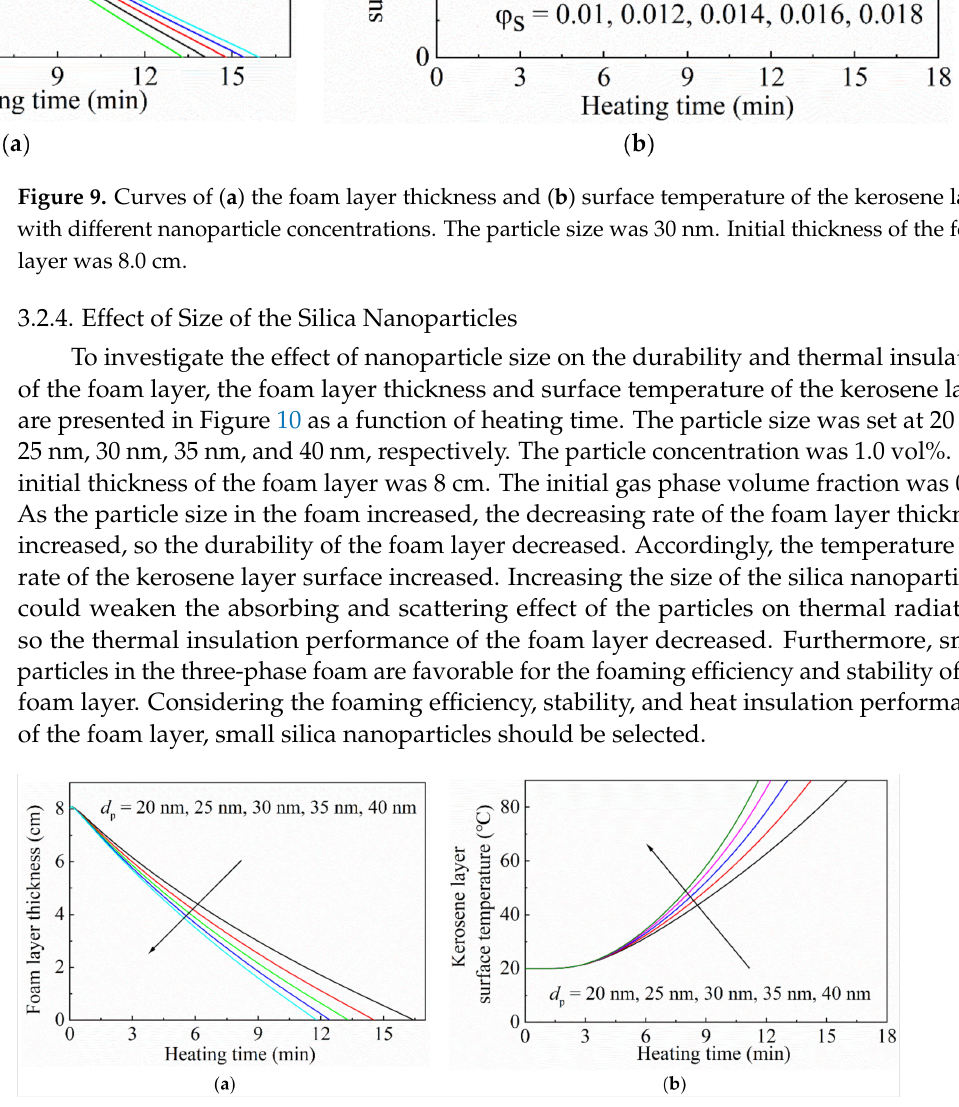
Figure 10. Curves of ( a ) the foam layer thickness and ( b ) surface temperature of the kerosene layer with different nanoparticle sizes. The particle concentration was 1.0 vol%. The initial thickness of the foam layer was 8.0